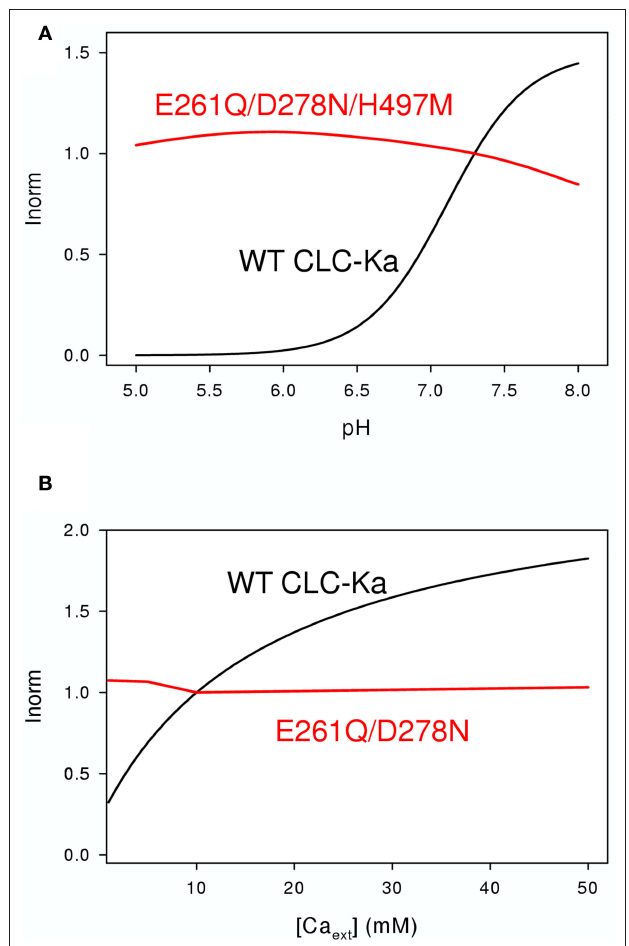
Figure 6 | effects of extracellular pH (A) and [Ca 2 + ] (B) on WT CLC-Ka (black line) and the mutants (red lines) e261Q/D278N/H497M (A) and e261Q/D278N (B) schematically drawn according to the results of gradogna et al. (2010)